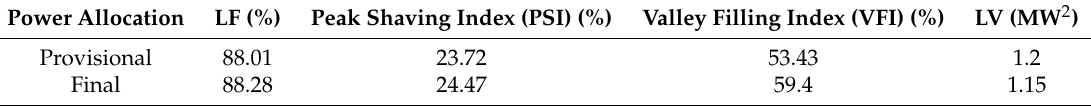
Table 6. Comparison between the provisional and final power allocation.